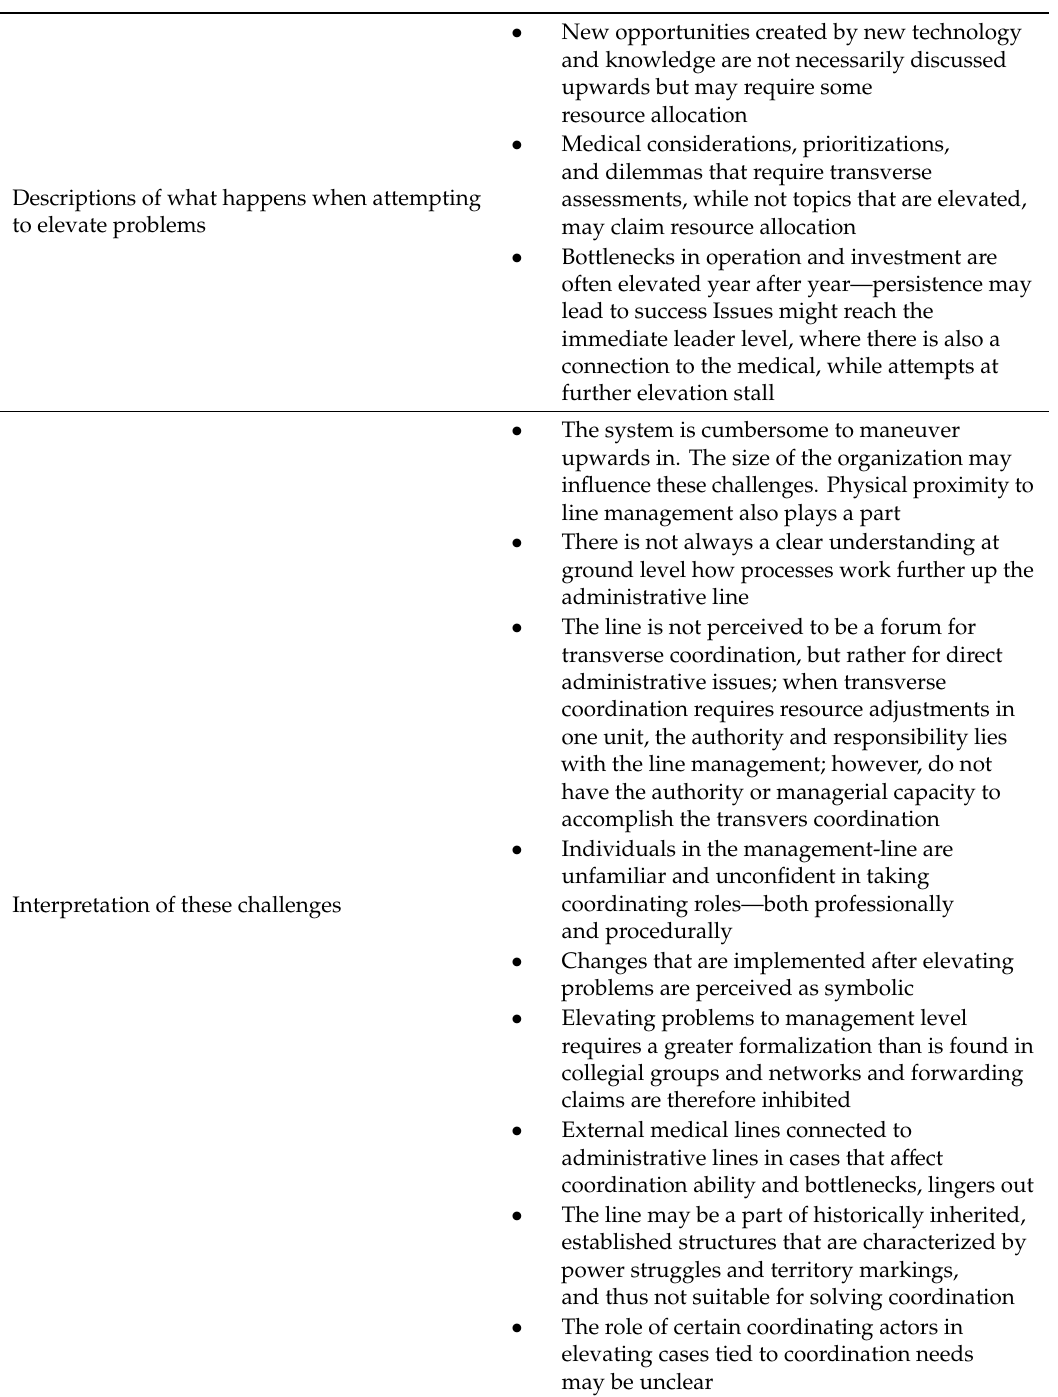
Table 12. Initiative from the bottom up—elevating problems in the line.